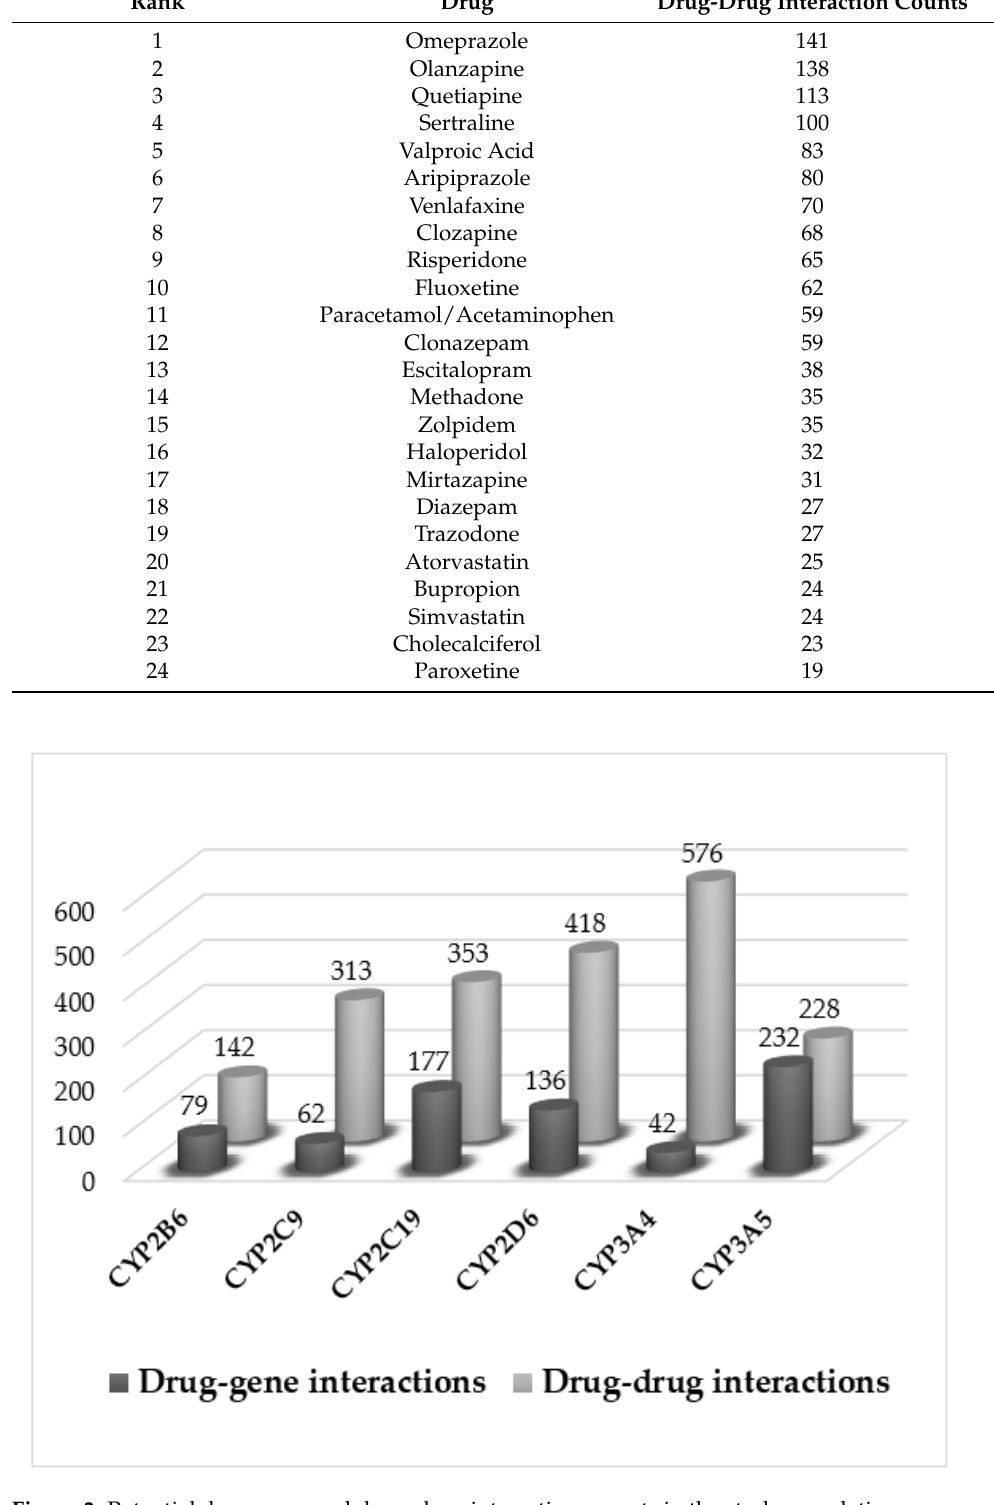
Figure 2. Potential drug–gene and drug–drug interactions counts in the study population.